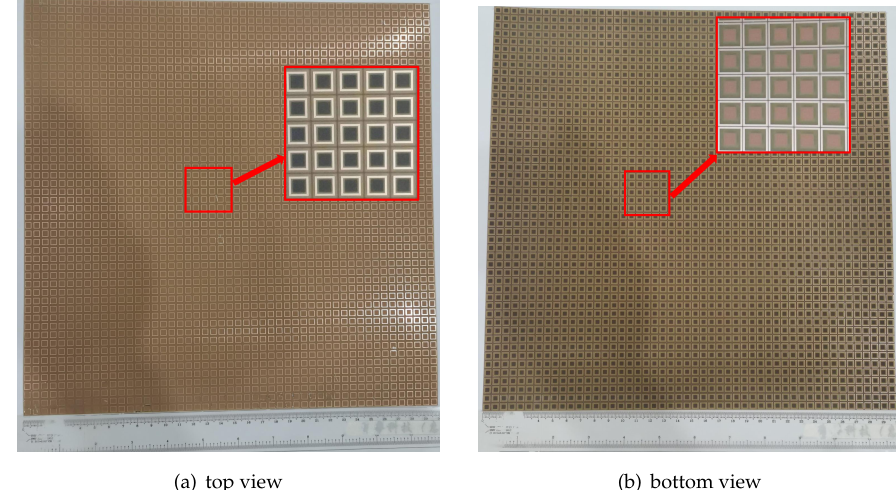
Figure 9. Photos of the triple band-pass FSS fabricated prototype.